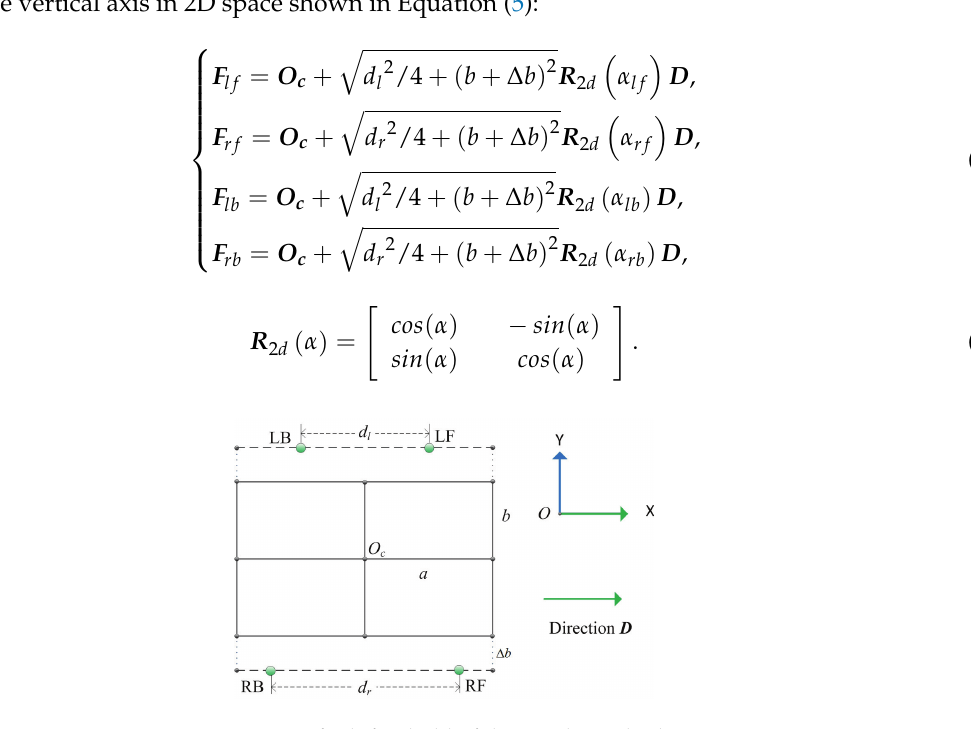
Figure 3. Default foothold of the quadruped robot.